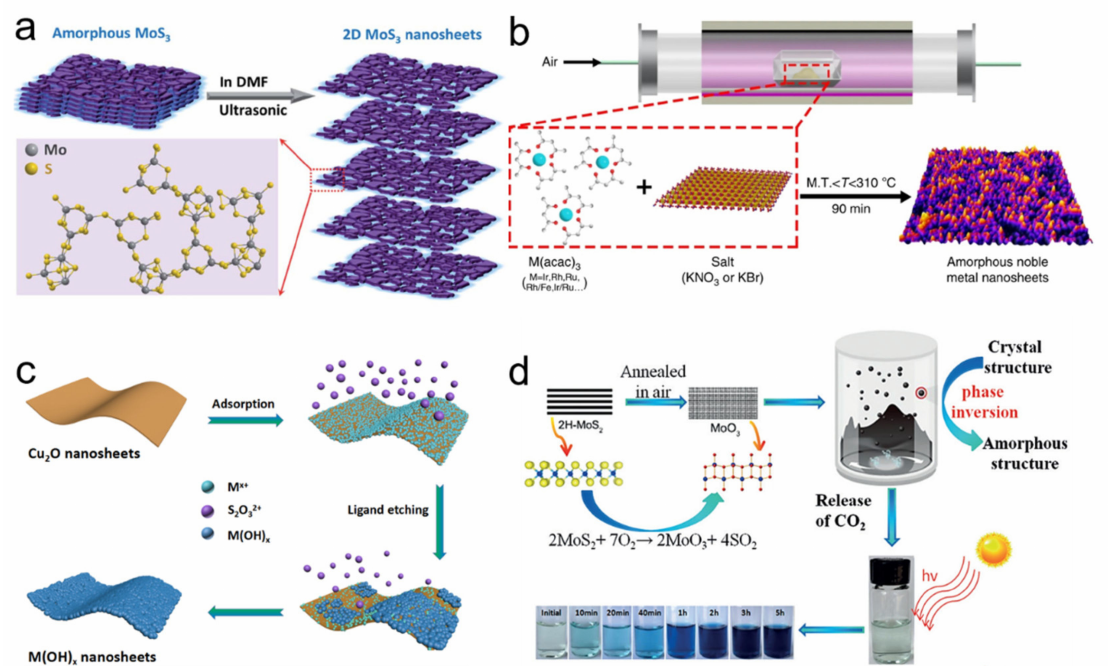
Figure 1. ( a ) Schematic illustration of exfoliation 2D amorphousMoS 3 nanosheets and their chemical structure. Reprinted with permission from Ref. [23]. Copyright Royal Society of Chemistry, 2019. ( b ) Schematic illustration of the general synthetic process for amorphous noble metal nanosheets. Reprinted with permission from Ref. [33]. ( c ) The schematic illustration of the synthesis of amorphous metal hydroxide nanosheets. Reprinted with permission from Ref. [28]. Copyright Royal Society of Chemistry, 2019. ( d ) Schematic illustration of the formation mechanism for amorphous MoO 3 nanosheets. Reprinted with permission from Ref. [31]. Copyright Wiley-VCH,